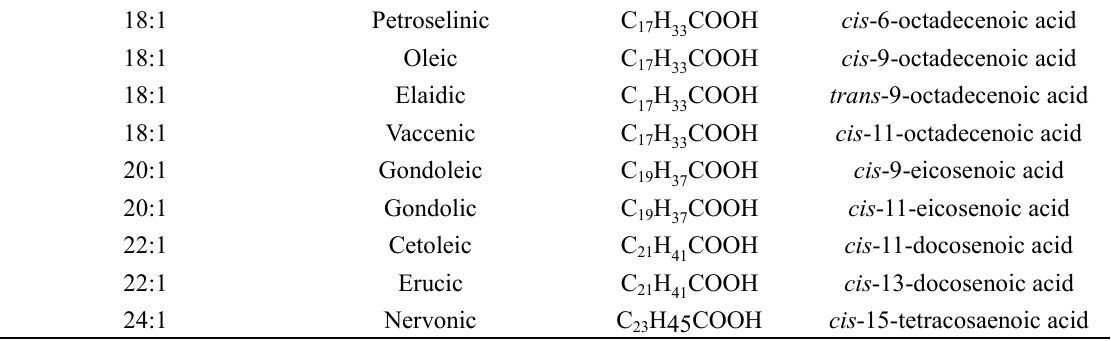
Table 2. Fatty acid content of different oils, nuts, fruits, seeds and animal